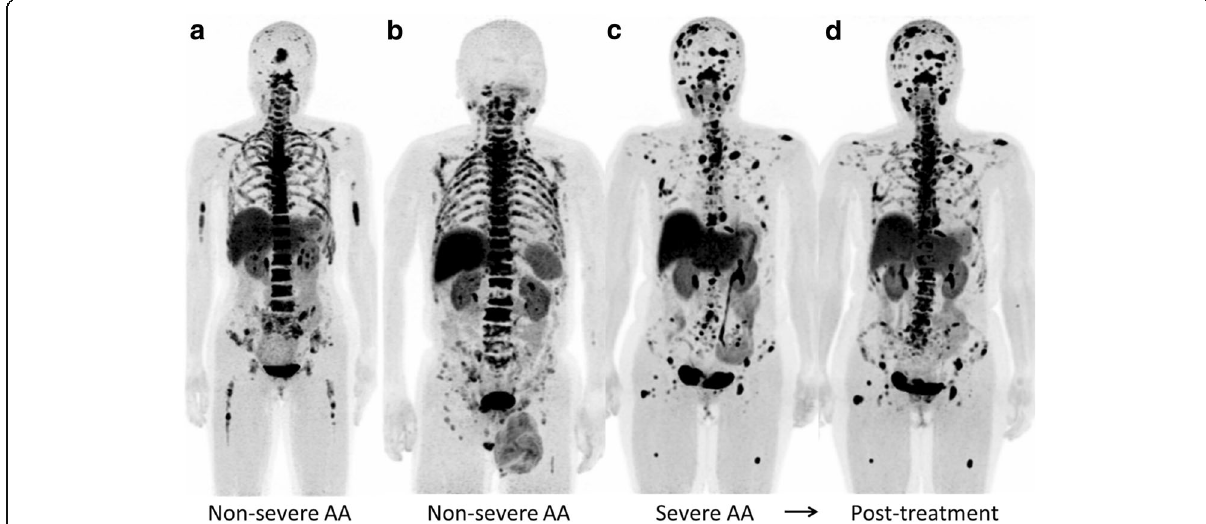
Fig. 3 Maximum intensity projection 18 F-FLT PET images of AA patients ( a – d ). Non-severe AA patients exhibited heterogeneously decreased 18 F-